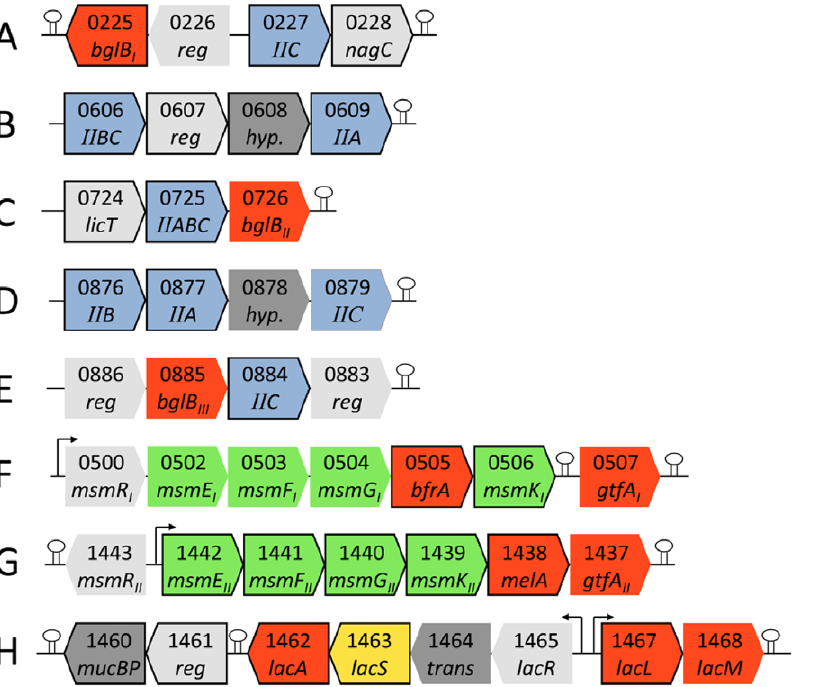
Figure 3. Organization of gene clusters encoding upregulated genes by potential prebiotic oligosaccharide stimulation. All genes are listed with locus tag number and gene name (PTS permeases are shown with domain name; regulators, hypothetical proteins and transposons are abbreviated as reg, hyp. and trans respectively). Gene product functions are colored red for glycoside hydrolases, light grey for transcriptional regulators, blue for PTS permease domains, dark grey for proteins unrelated to carbohydrate metabolism, green for ABC transporter domains and yellow for the GPH permease. All upregulated genes (Table 2) are shown with framed boxes, CRE regulatory sites are represented by arrows and predicted rho-independent transcription terminators [49] by stem